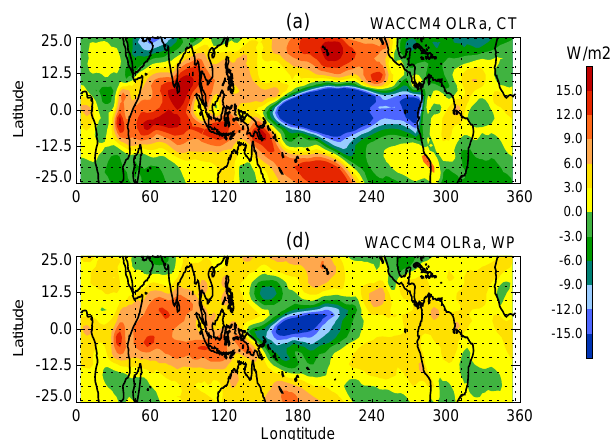
Fig. 3. Averaged OLR anomalies for R2–R1 (a) and R3–R1 (b) . Contour interval, ± 3Wm − 2 Figure 3. Averaged OLR anomalies for R2 − R1 (a) and R3 − R1 (b). Contour interval, ±3 W/m 2 .